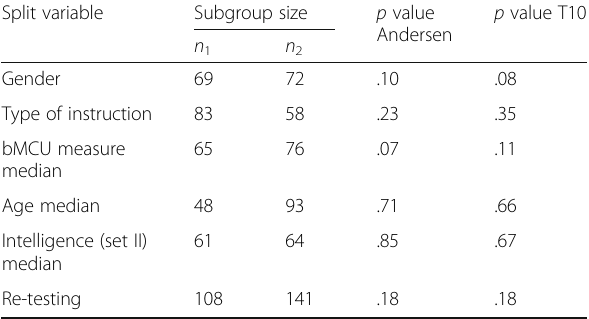
Table 1 Results of Andersen ’ s conditional likelihood ratio tests and the nonparametric T10-statistics with different split